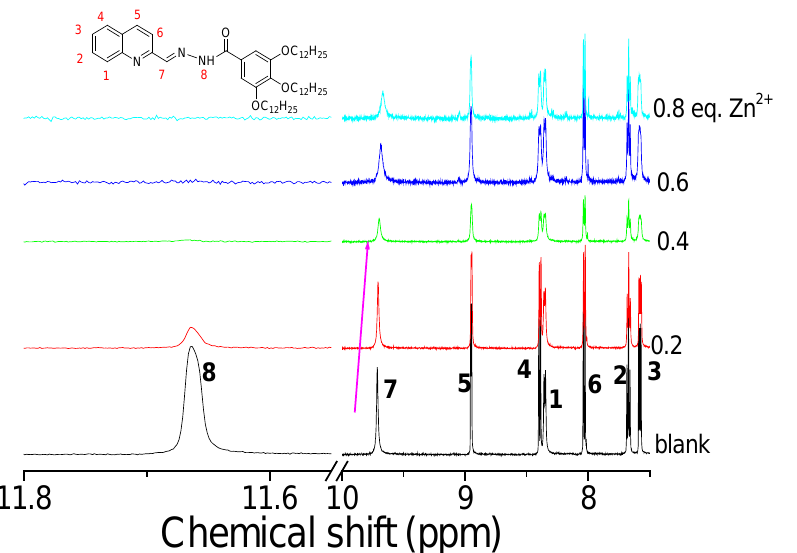
Figure 14. 1 HNMR titration of solution 1 in DMSO- d 6 by Zn 2+.